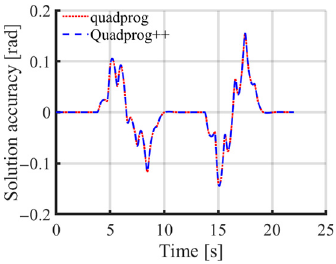
Figure 7 Comparison of the solution accuracy of quadprog and Quadprog 11